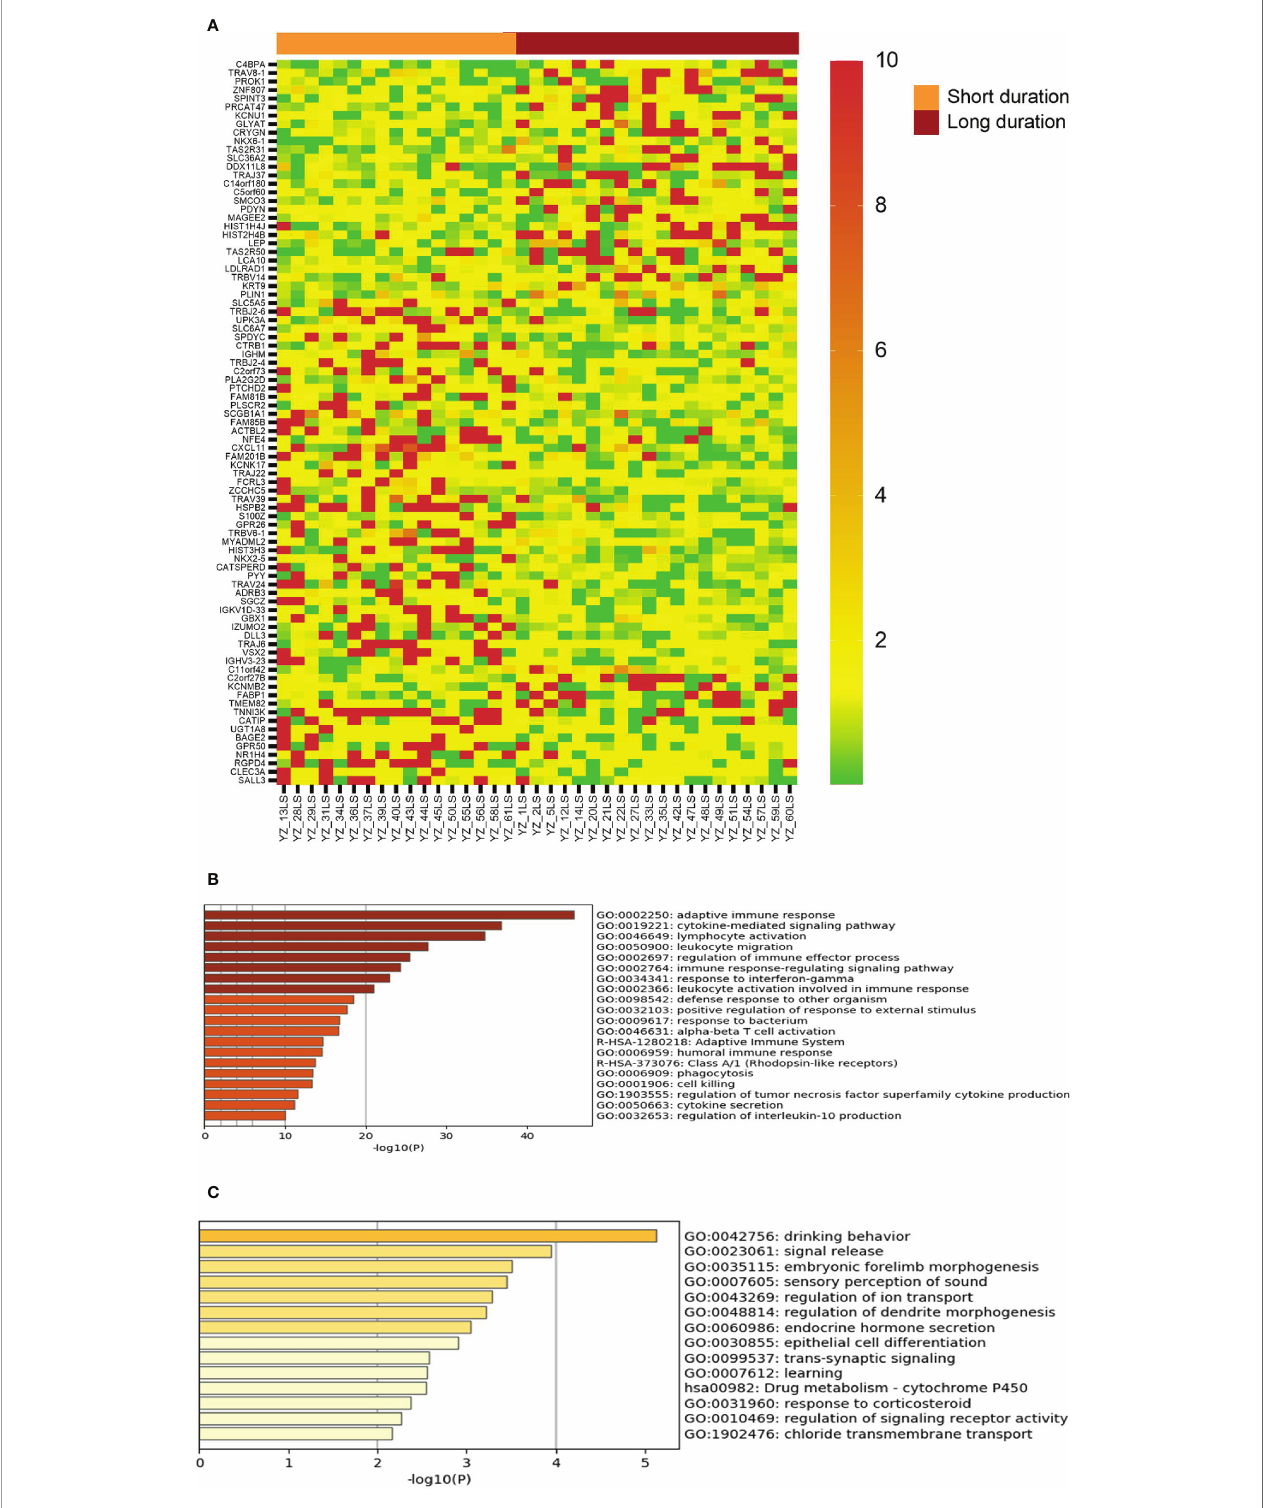
FIGURE 4 | Genes with differential expression between lesions with short duration and lesions with long duration. (A) The LS/NLS ratios of 85 genes with >2 fold up or down regulated between lesions of <12 month duration and lesions >12 month duration. (B, C) Top biological genes enriched or decreased in short and long duration lesions,